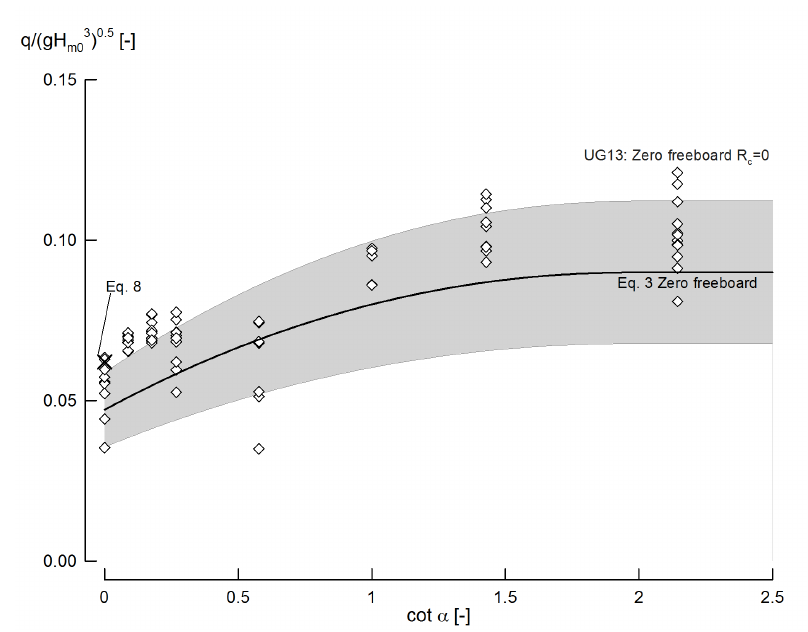
(cid:113) gH 3 as a function of the slope angle cot α m 0